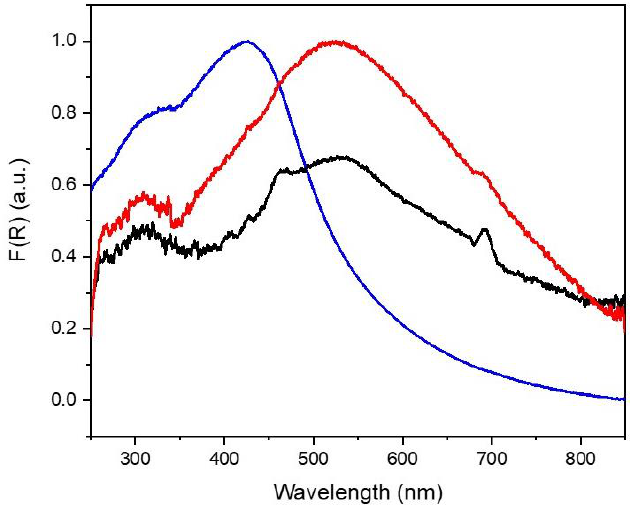
Figure 2. Diffuse-reflectance UV–visible spectra of commercial TiN (blue line), TiN tubes (black line) and Ru(2)-TiN tubes (red line).